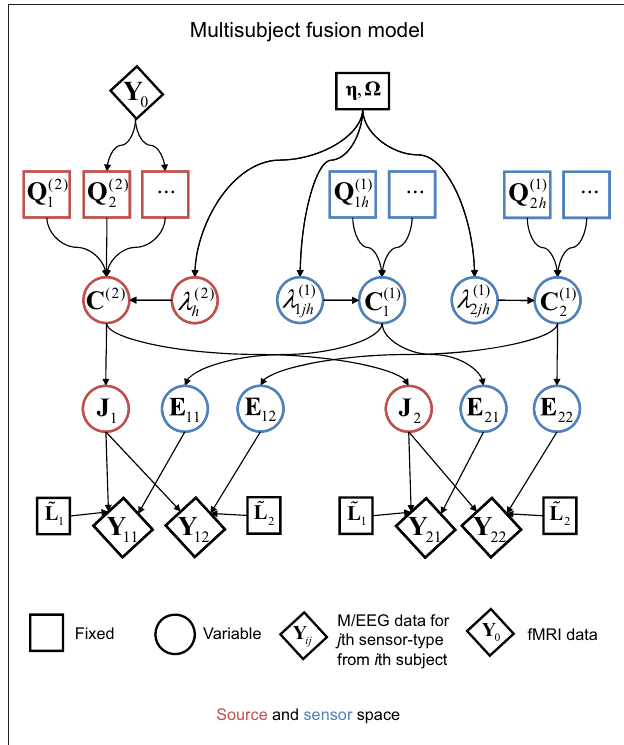
Figure 10 | The extension of the generative model in Figure 7 to group-optimization of source priors, for i = 1–2 subjects, each with data from j = 1–2